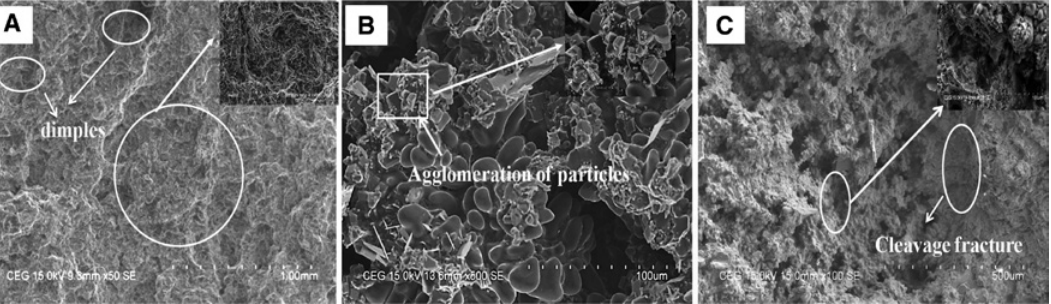
Figure 13: SEM images of fracture surfaces of the (A) Al alloy, (B) Composite under 10 min AT 20 and min HT, and (C) Composite under 20 min AT and 30 min